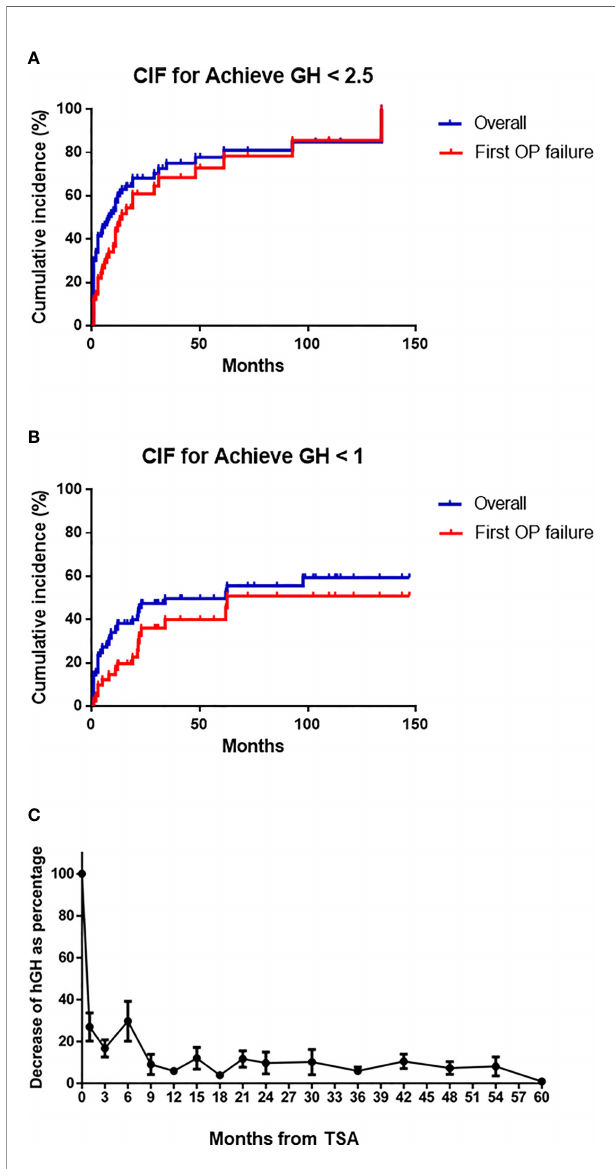
FIGURE 1 | Cumulative incidence function (CIF) for achieved biochemical remission in the whole group and patients with fi rst surgery failure. (A) GH <1 ng/ml. (B) GH <2.5 ng/ml. (C) The decreased percentage of hGH level in the whole group at different time